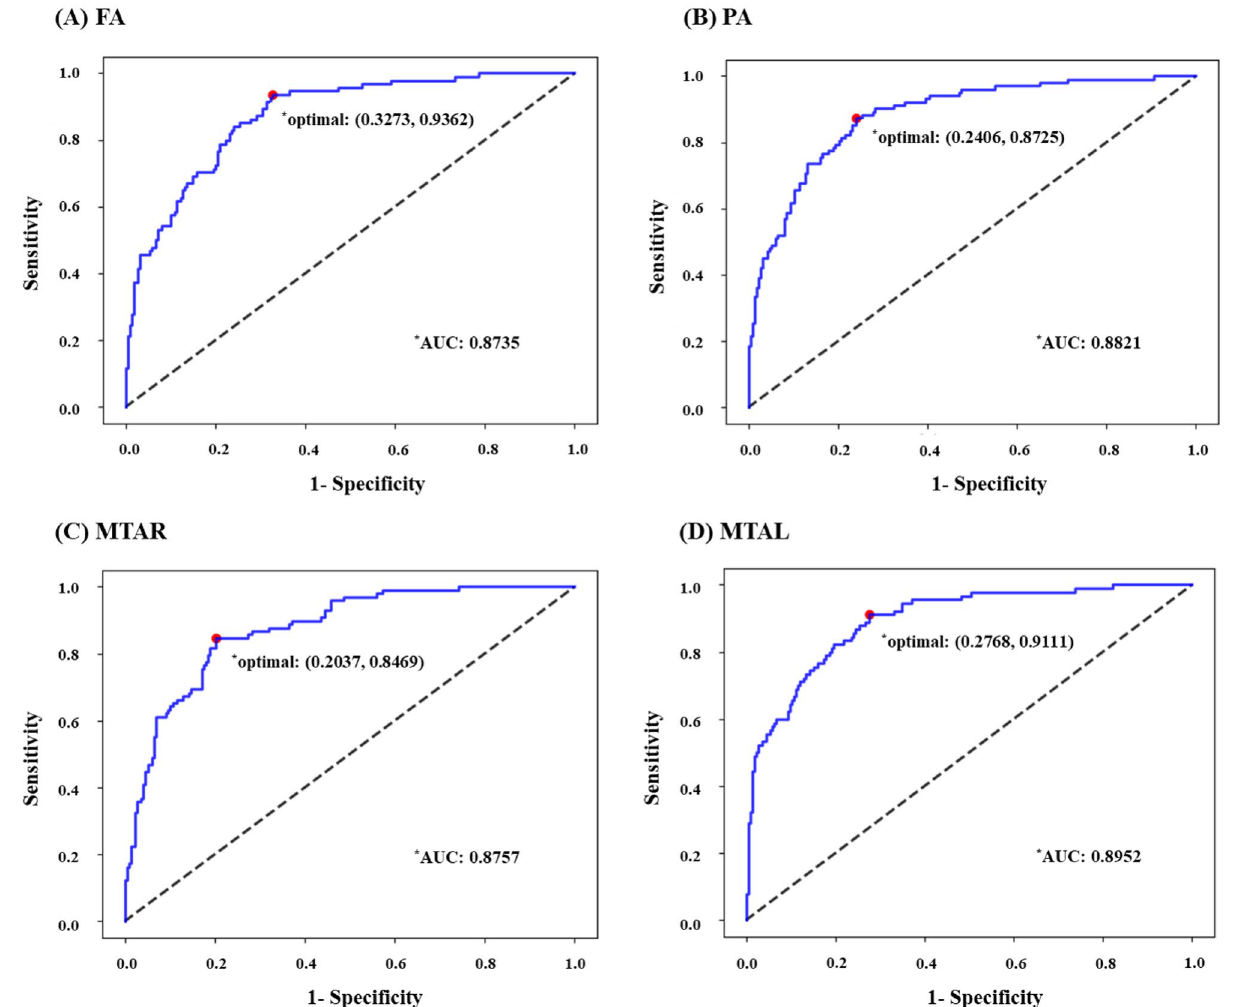
Figure 3. ROC Curve for binary classification of atrophy. FA frontal atrophy, PA Parietal atrophy, MTAR medial temporal atrophy, right, MTAL medial temporal atrophy,